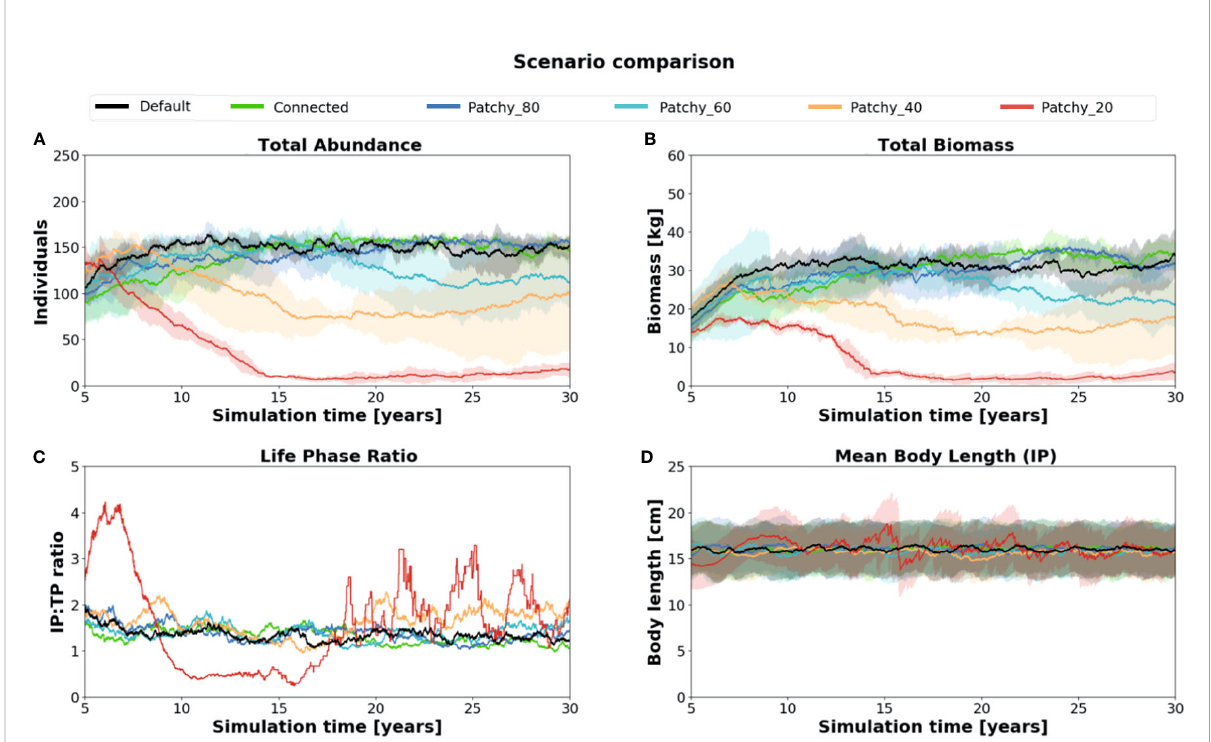
FIGURE 3 Comparison of key population characteristics of simulation runs under different scenarios: (A) total abundance, (B) total biomass (C) life phase composition (IP : TP), and (D) mean body length of (female) fi shes in their initial phase (IP). Standard deviation is indicated as shaded areas around the